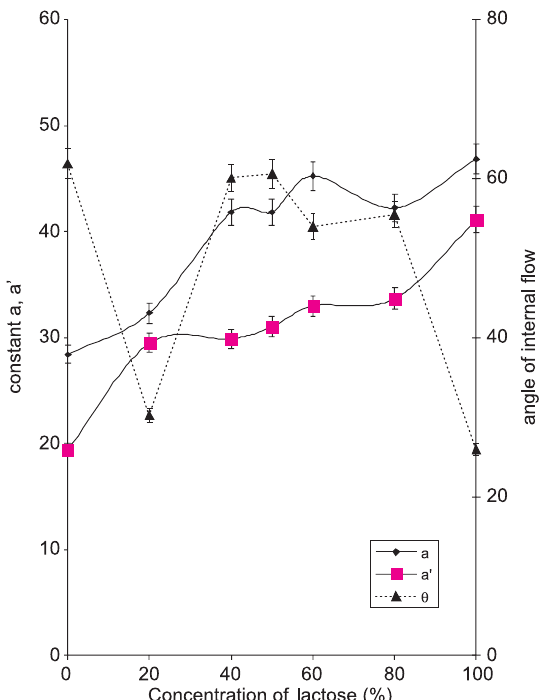
FIGURE 3 - Powder characteristics as a function of the concentration of lactose in binary mixtures with chloroquine